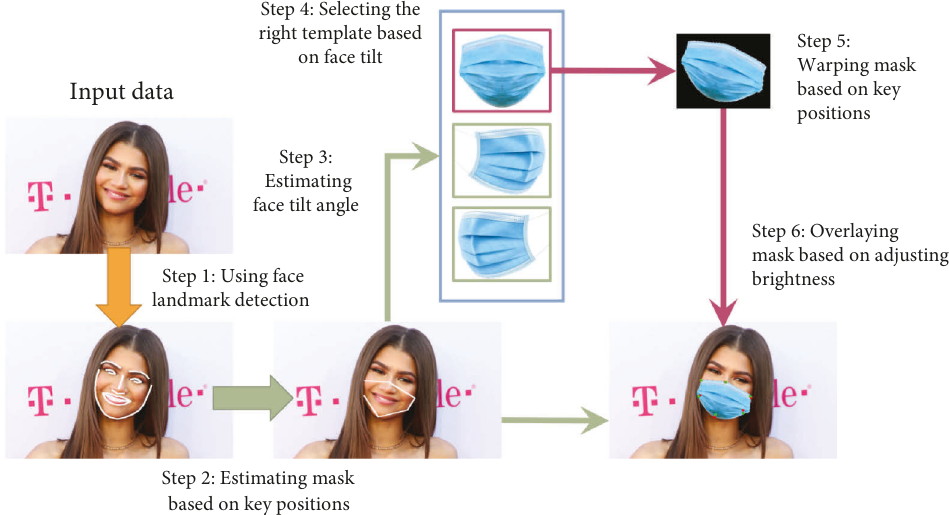
Figure 16: Block diagram of MaskTheFace [51].